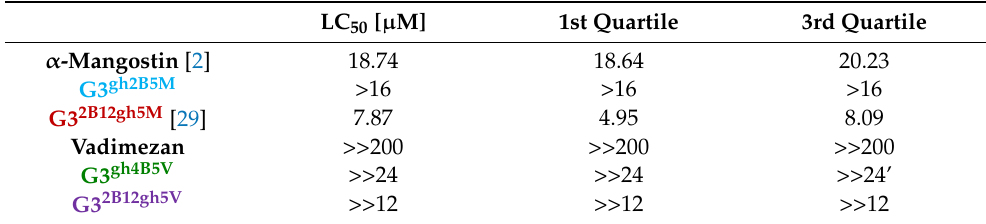
Table 3. The half maximal lethal concentration (LC 50 ) values estimated after 7 days incubation of C. elegans nematodes with free α M and V, or their dendrimer conjugates. Data are presented as medians with the first and third quartile. Presented values were calculated with AAT Bioquest IC 50 calculator [46].